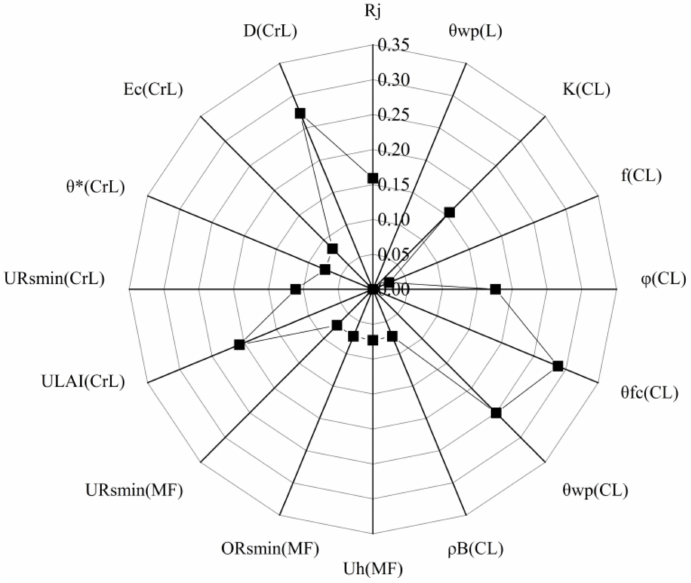
Figure 3. Total order sensitivity index of sixteen parameters of the DHSVM in Sobol’s sensitivity analysis [48] (The abbreviations of 16 parameters are shown in Table